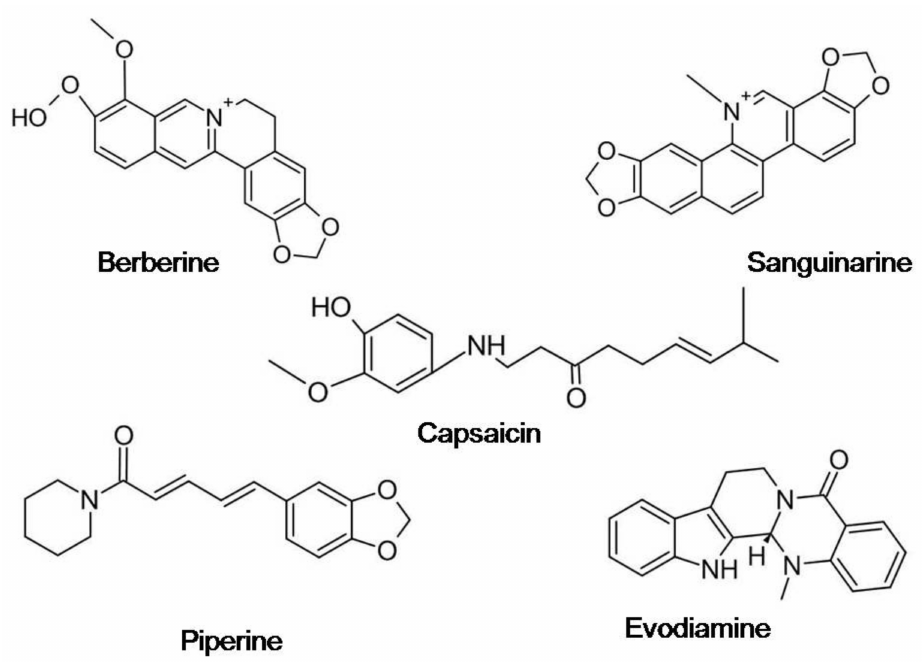
Figure 4. Chemical structures of some lead alkaloids. Rohitukine is a chromone alkaloid, that was initially isolated from the leaves and stems of Amoora rohituka widely used in the Ayurvedic system of medicines [107]. It has anti-fertility, and immunomodulatory effects [108]. The unique chemical structure of ro- molecules [109]. P-276-00 and flavopiridol are two rohitukine analogs presently